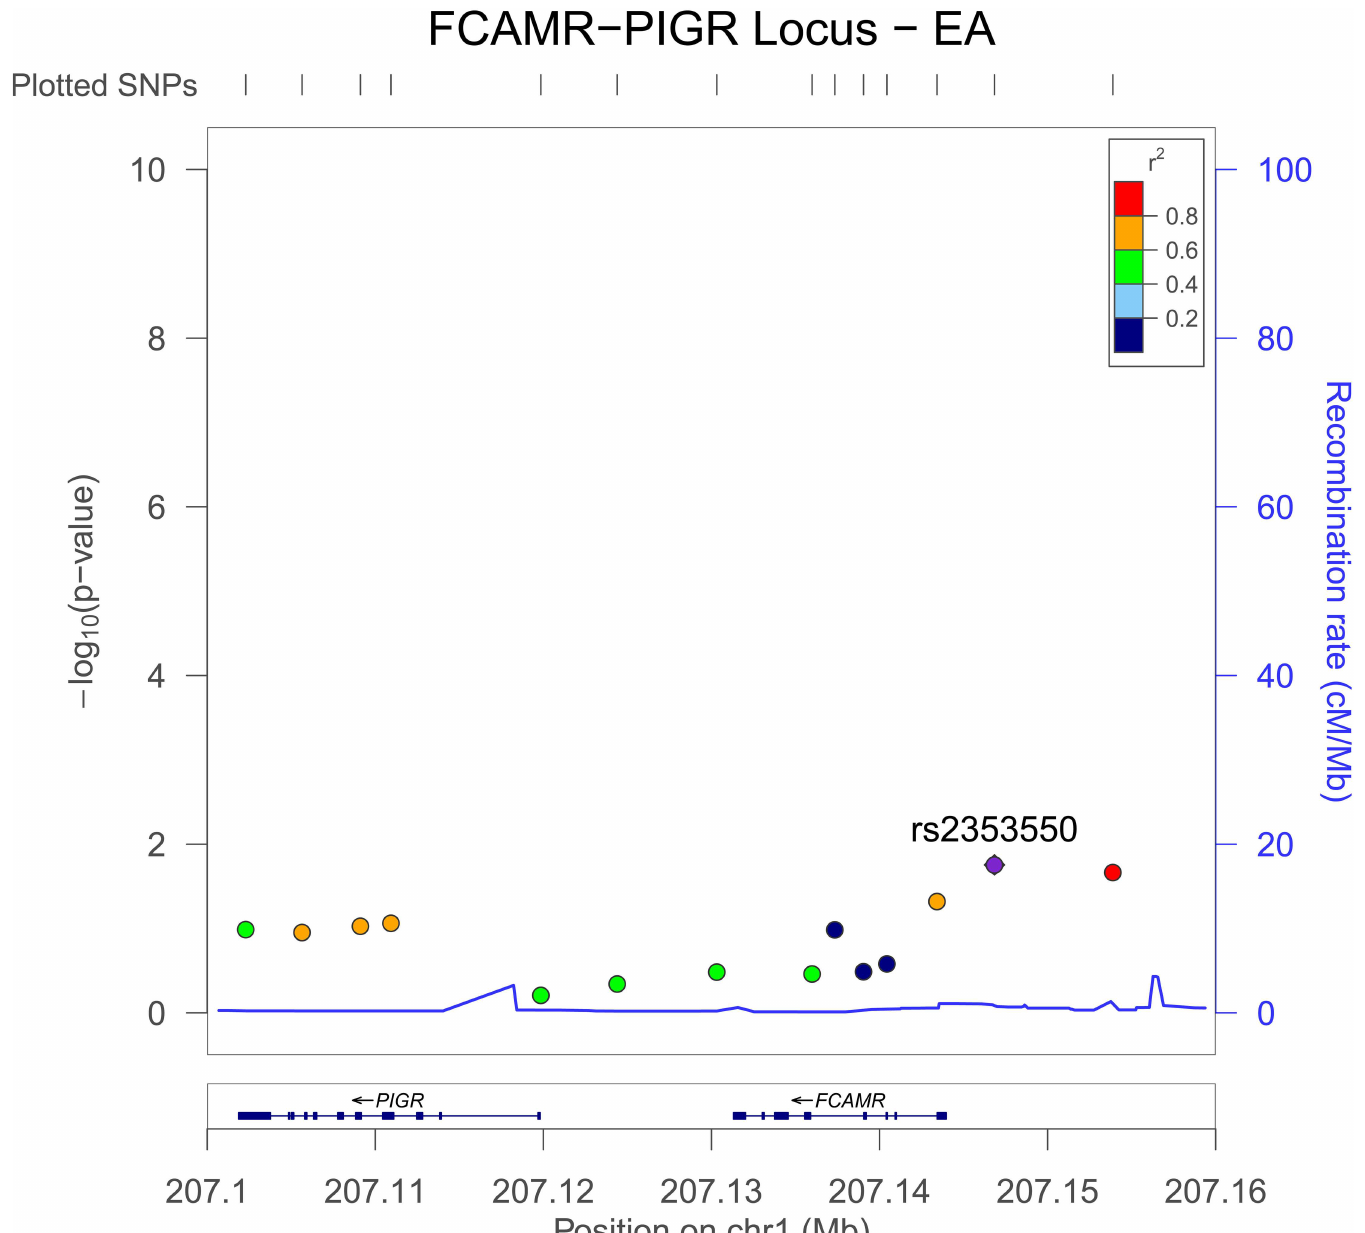
Fig 6. LocusZoom Plot of FCAMR-PIGR locus for European-Americans. Similar to what was observed in the African-Americans( Fig 5 ) substantialLD is observedin the FCAMR-PIGR regionparticularlybetweenthe replicated variant (rs185674)and variants in PIGR . For plotting1000 Genomes data is used (population= EUR) in genomebuild